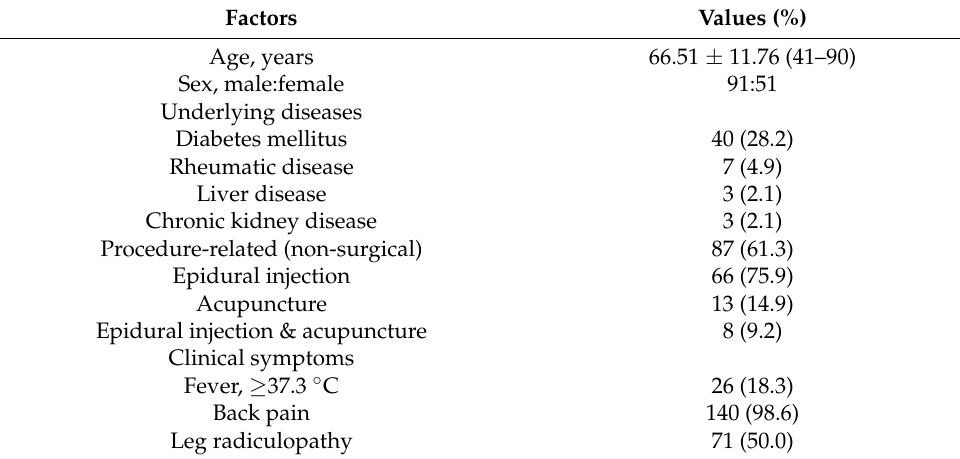
Table 1. Clinical and demographic data. CCI, Charlson’s comorbidity index; MR, magnetic resonance; WBC, white blood cell; ESR, erythrocyte sedimentation ratio (normal range < 20 mm/h); CRP, C-reactive protein (normal range < 0.5 mg/dL); $, US dollar (mean exchange rate from March 2015 to December 2021; 1 US dollar = 1146.44 Korea Won); SF-36, short form 36; Data are presented as the mean ± standard deviation or frequency